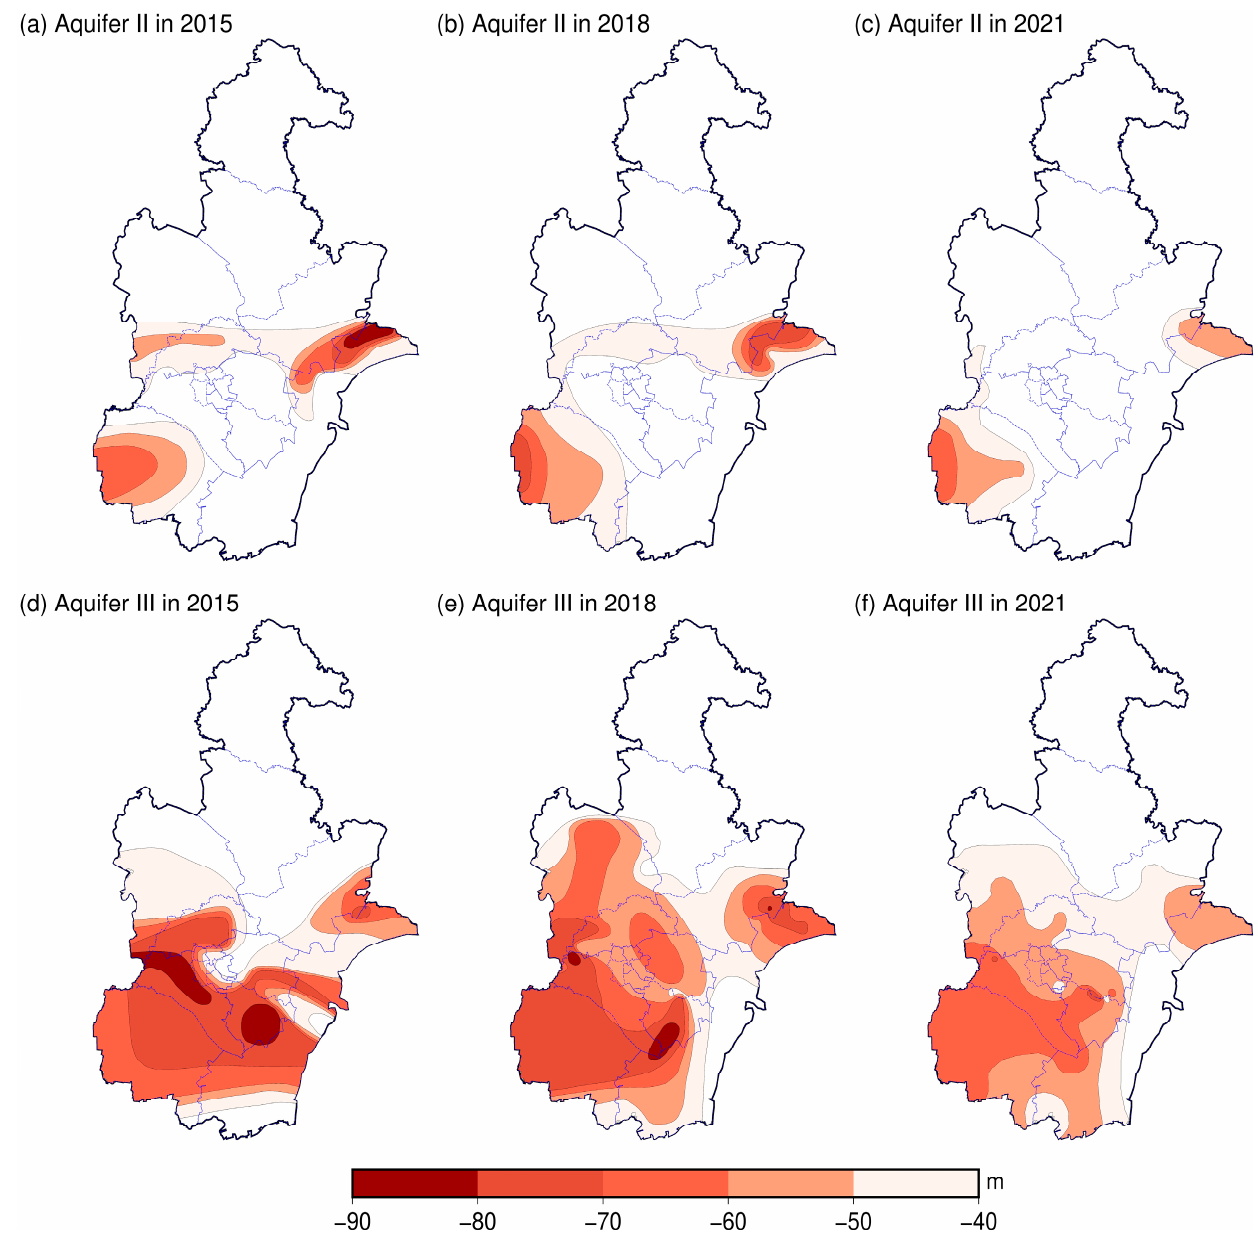
Figure 12. The contour maps of hydraulic heads ( − 40 m, − 50 m, − 60 m, − 70 m, − 80 m) in Aquifers II and III in 2015, 2018, and 2021 in Tianjin. (Data source: Tianjin Water Resources Bulletins [10]). A local institute has been operating integrated extensometers and piezometers for over one decade at a site in Xinkou town, Xiqing District, which provides critical data for addressing the relationship between aquifer deformation (compaction, expansion) and hydraulic head changes. The location of the field site is marked in Figure 1, approximately 5 km north to Jinghai District, where almost the entire district is still subsiding (>5 mm/year, Figure 10b). The Xinkou observational site comprises six borehole extensometers and four groundwater wells terminated at different depths (Figure 13a). The cumulative subsidence from 1985 to 2018 is about 1.6 m in this area [44].